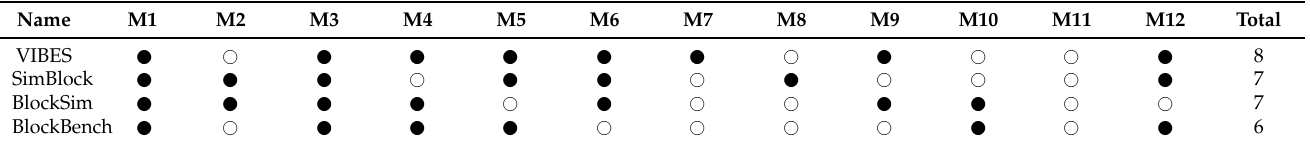
Table 3. Comparison of the metrics of typical simulators.